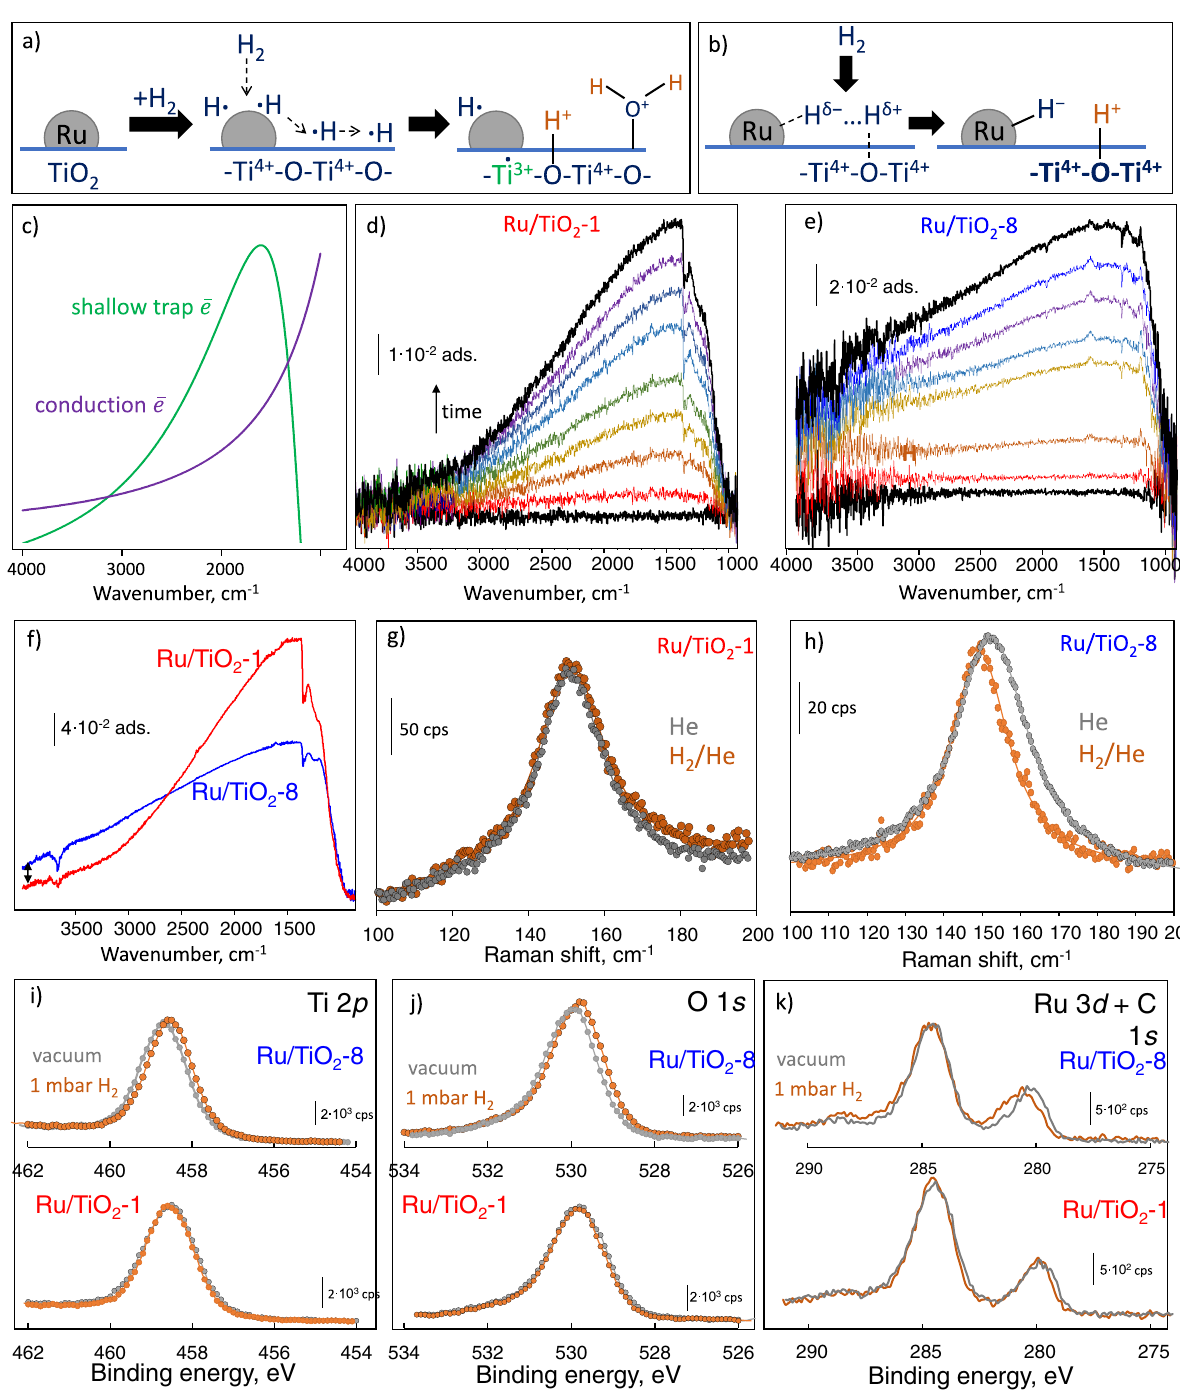
Fig. 3 | Hydrogen activation over Ru/TiO 2 . a Hydrogen spillover schematic over spectra for both samples at 250°C and 0.14bar H 2 . g , h In situ Raman spectra for Ru/TiO 2 . b H 2 binding on the metal-support interface. c Theoretical IR spectra for Ru/TiO 2 -1 and Ru/TiO 2 -8 at 200°C in He and H 2 /He fl ows, respectively (lines show free electrons in the TiO 2 conduction band and Ti 3+ shallow trapped electrons. Lorentziancurve fi tting). i – k NAP-XPSofRu/TiO 2 d , e Transmission FTIR transient spectra when switching from pure He to H 2 /He − 1 and Ru/TiO − 8, respectively. f Steady-state FTIR fl ow at 200°C on Ru/TiO 2 2